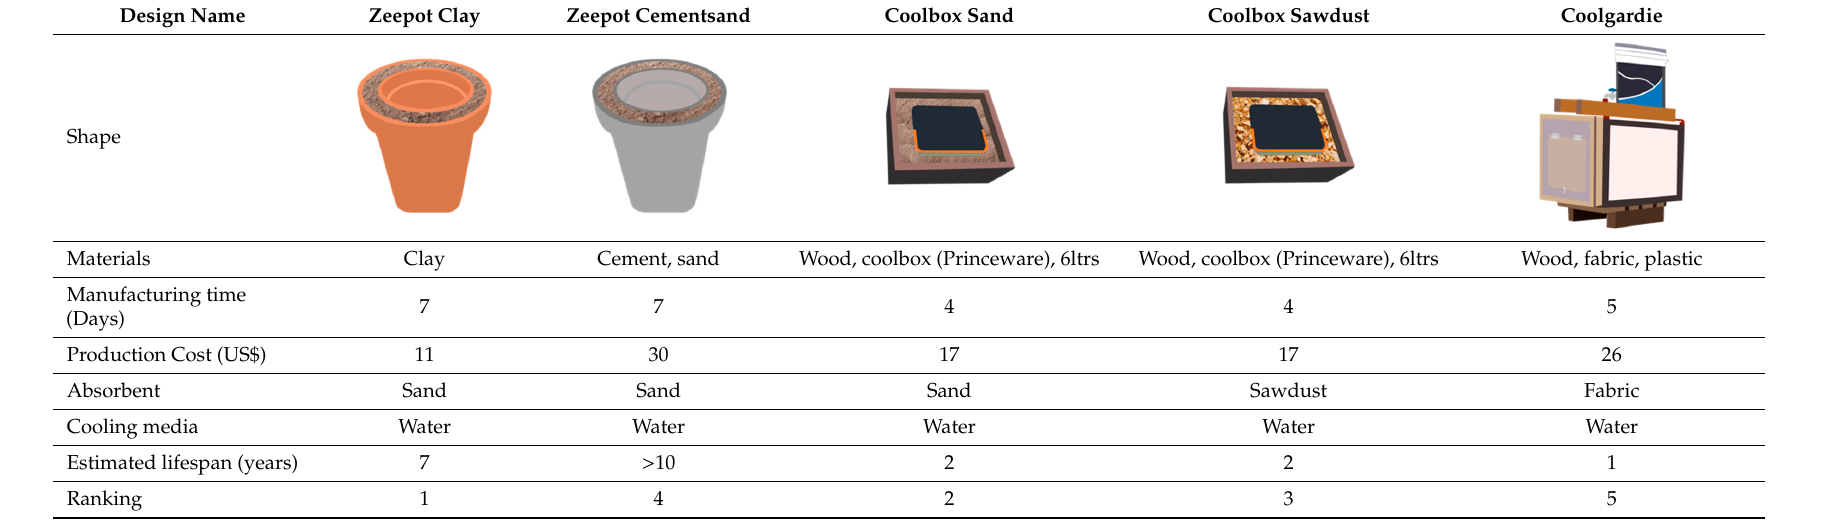
Table 1. PCD models developed by local designers and used in the first round of testing.